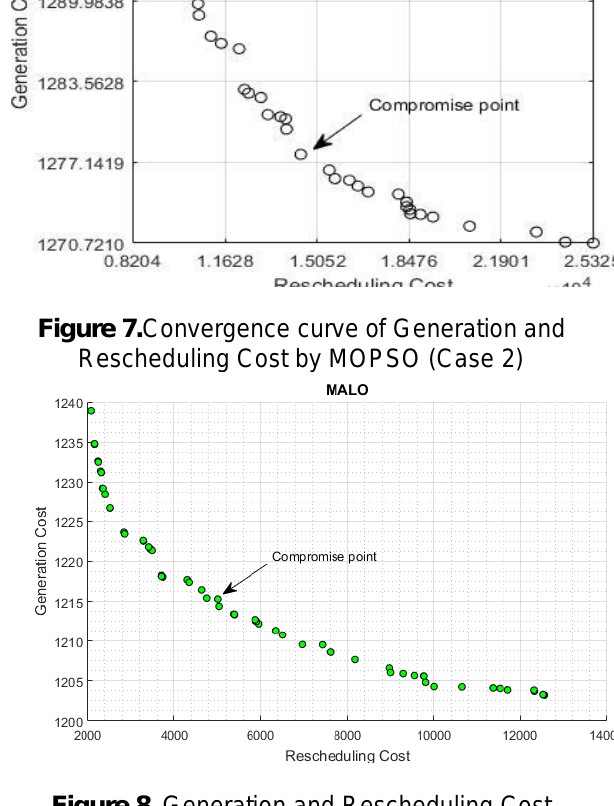
Figure 8. Generation and Rescheduling Cost Convergence curve by MOALO (Case 1)